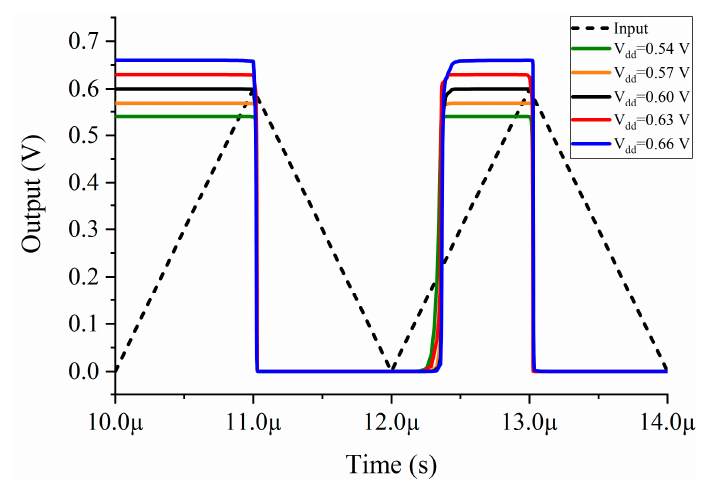
Figure 16. Post-layout simulated histogram for 100 runs of Monte Carlo for ( a ) LTP and ( b ) UTP.